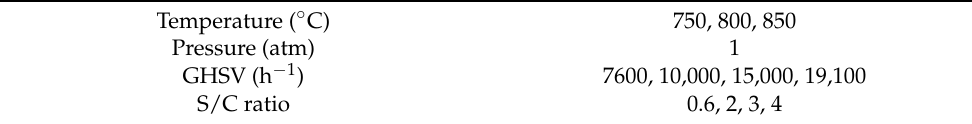
Table 2. Experiment